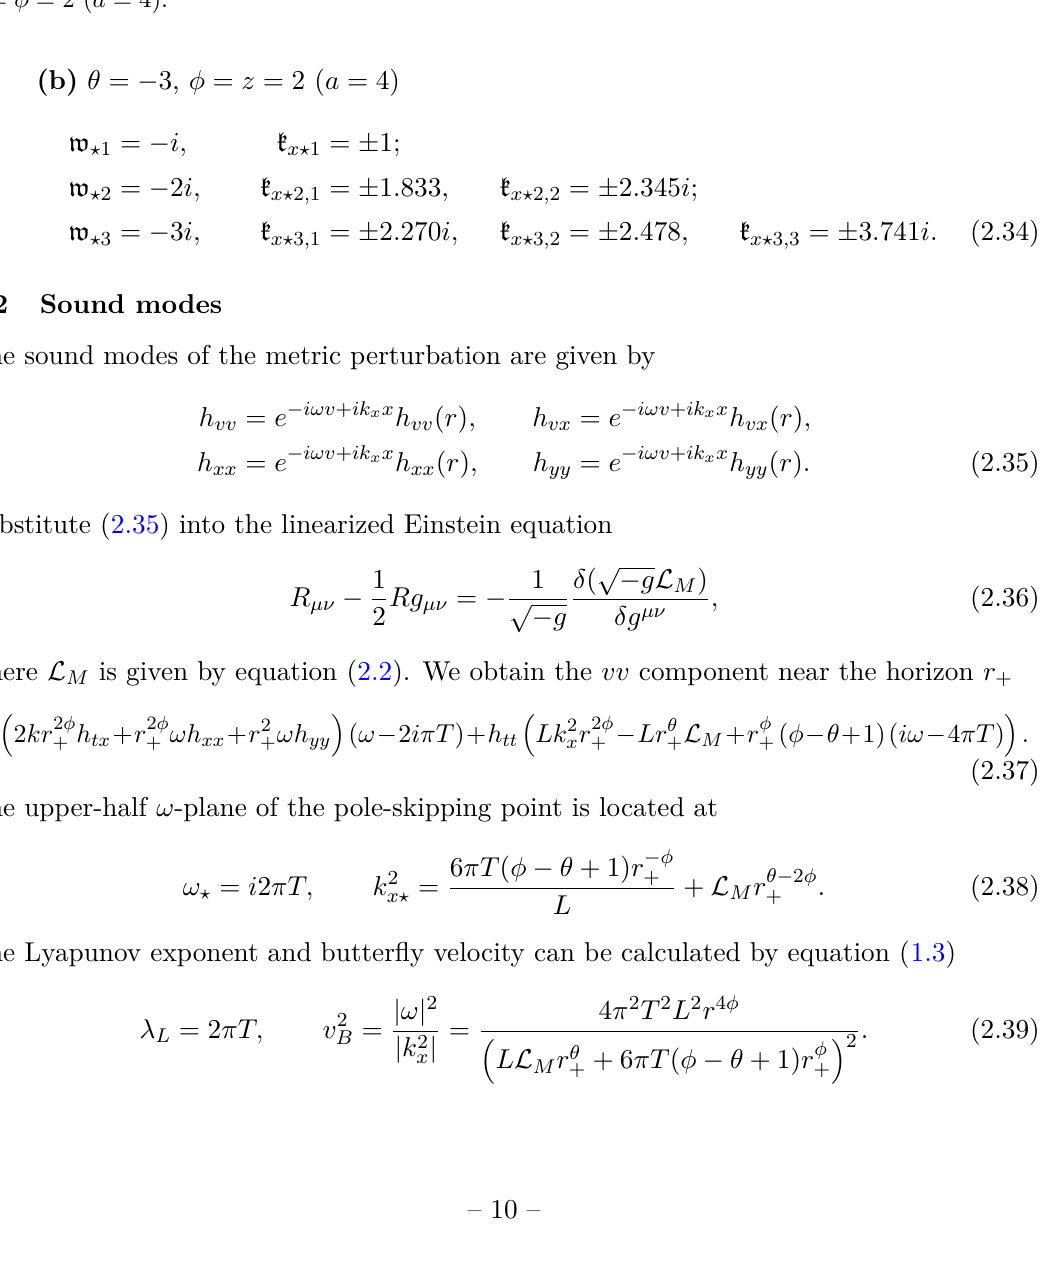
Figure 3 . The first three order pole-skipping points of tensor mode h y anisotropic system near Lifshitz points when a 6 = 0 . (a) θ = − 1 , z = φ = 2 ( a = 3 . 46 ); (b) θ = − 3 , z = φ = 2 ( a = 4